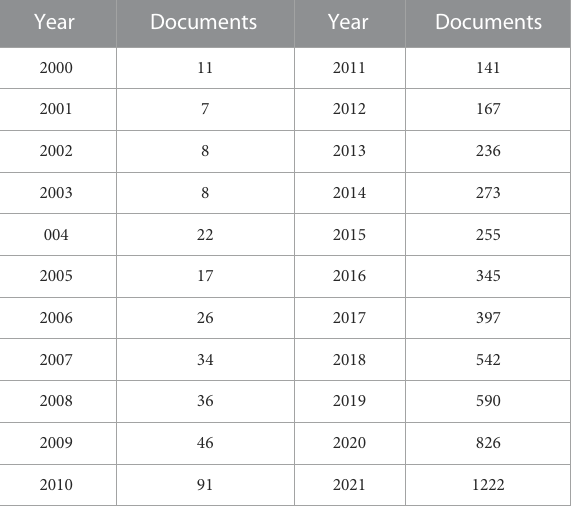
TABLE 2 Annual distribution of articles on ecological concrete documents from